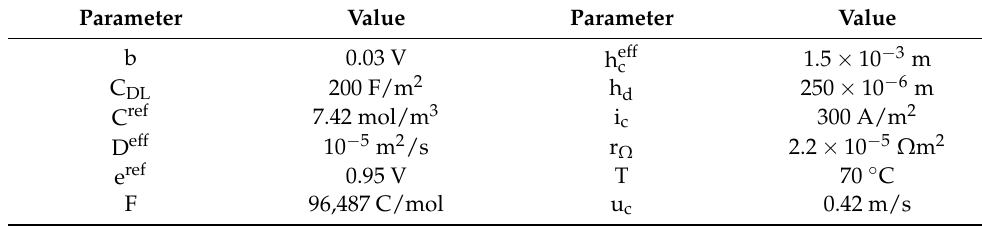
Table 2. PEMFC model parameter values.